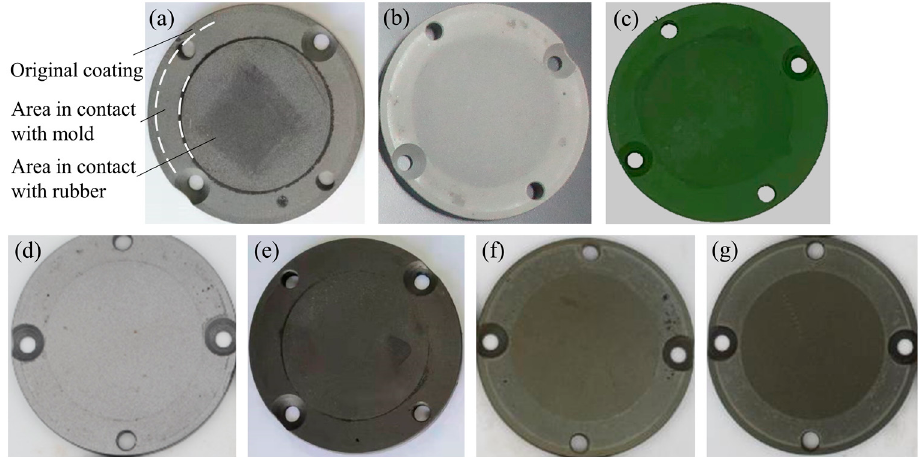
Figure 7. Specimens ( Φ 75 mm × 5 mm) after 10 vulcanizations: ( a ) without coating, ( b ) nano-ce- ramic coating, ( c ) bilayer waterborne PTFE coating, ( d ) Whitford Xylan 8840 coating, ( e ) PTFE coating, ( f ) PFA coating, ( g ) FEP coating.